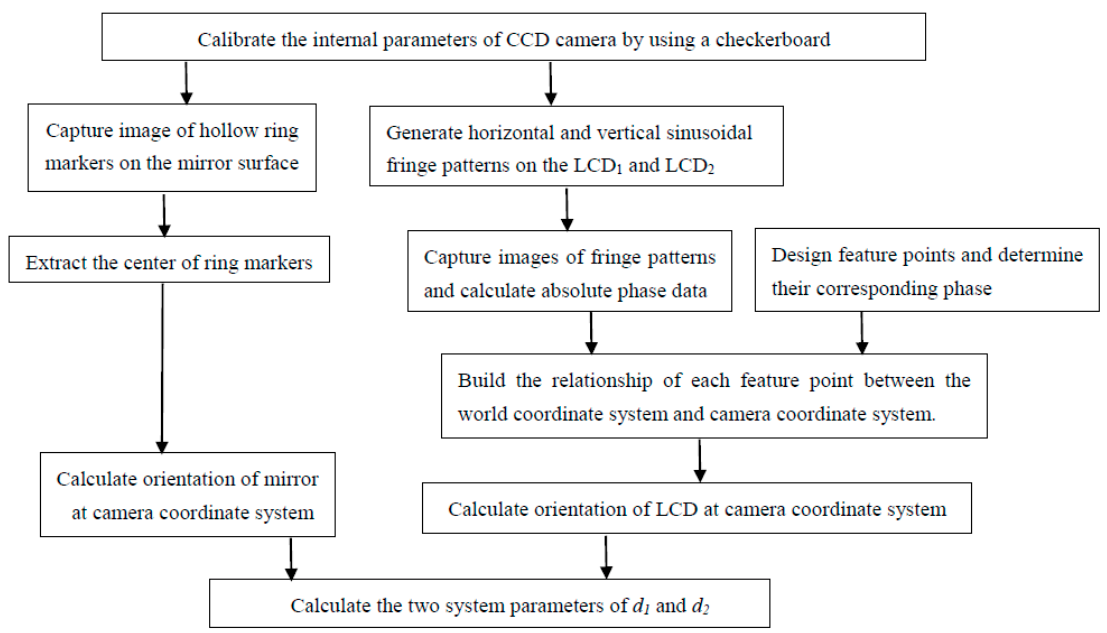
Figure 5. Calculation of d 1 and d 2.